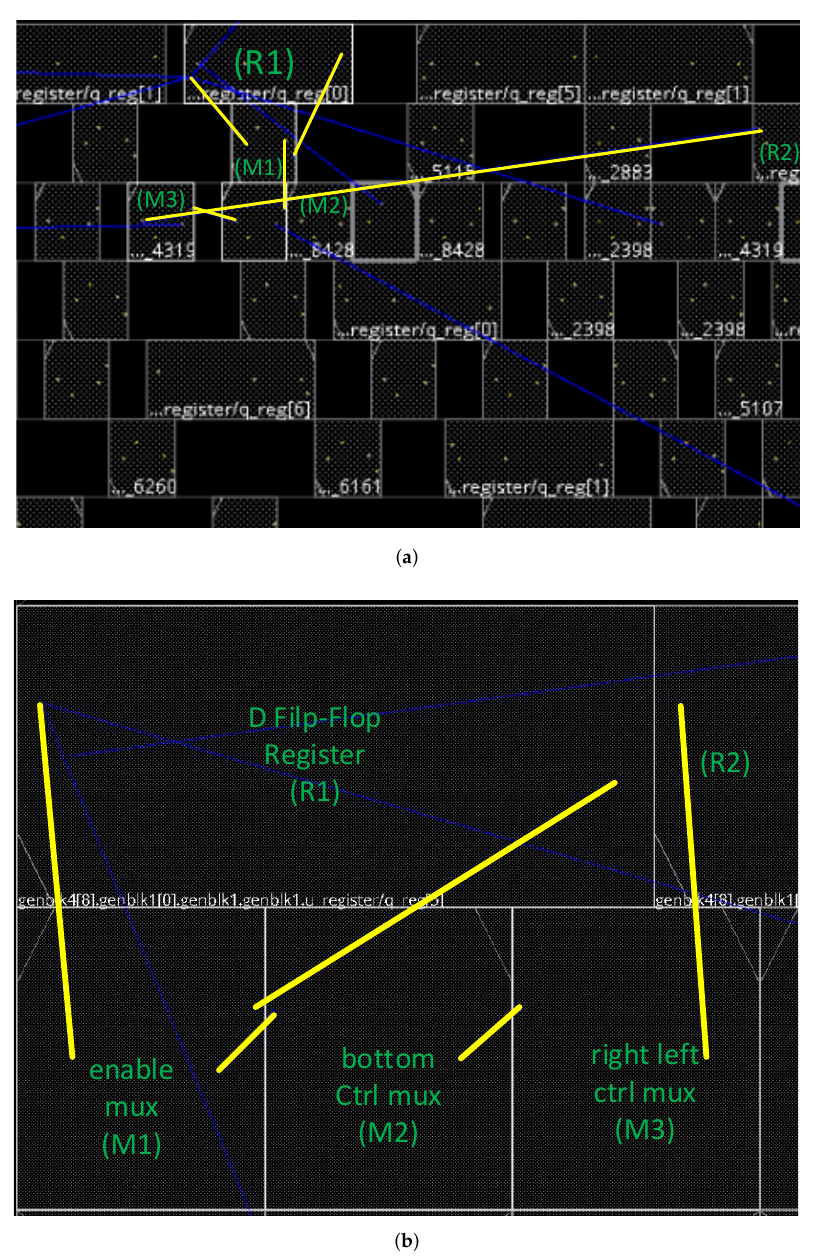
Figure 6. Placement of D-FF and Multiplexers in both Normal and SDP Flow. ( a ) Placement in Normal Flow. ( b ) Placement in SDP